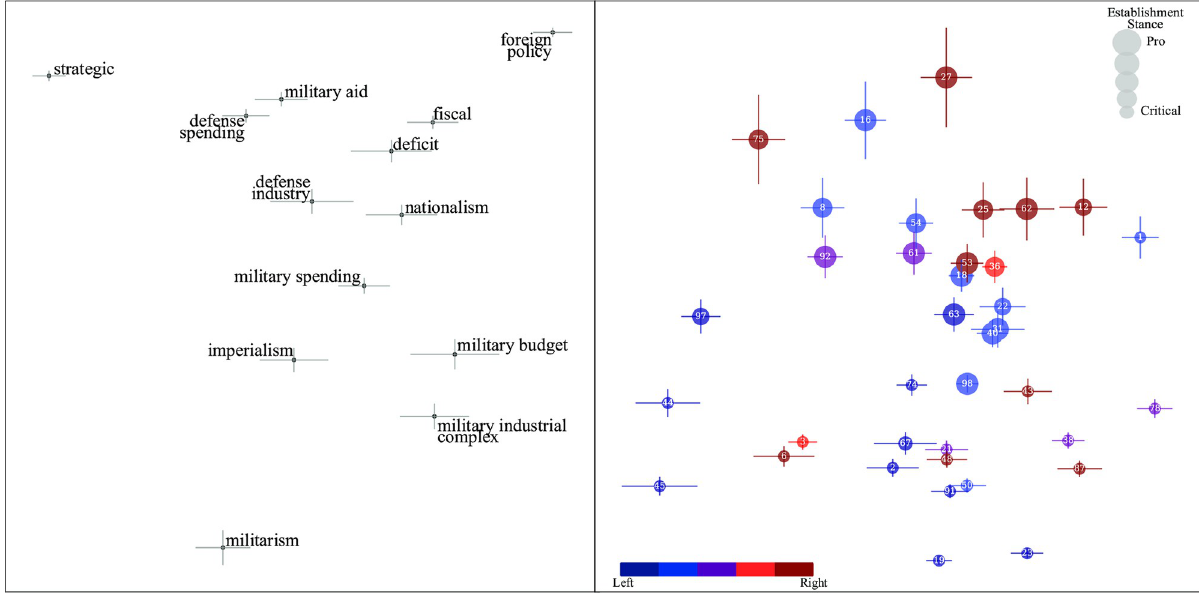
Fig 7. Pro-critical bias spectrum: Military spending. Generalized principal components for military spending.